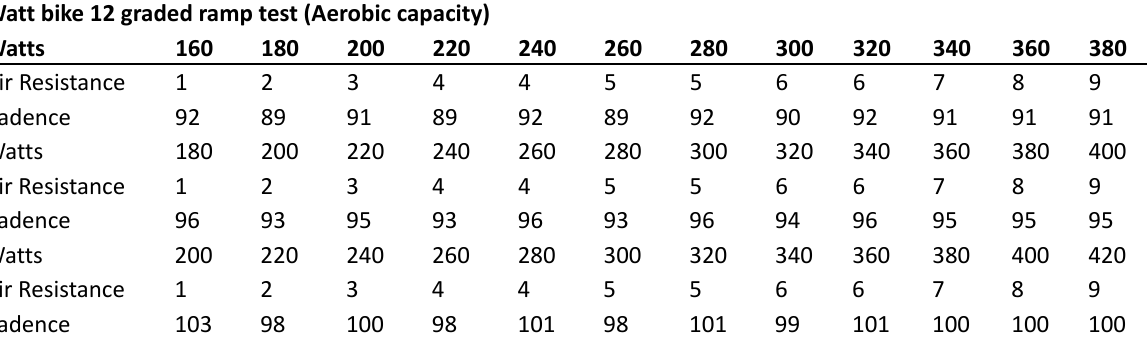
Table 2. Watt bike 12 graded ramp test (Aerobic capacity) Watt bike 12 graded ramp test (Aerobic